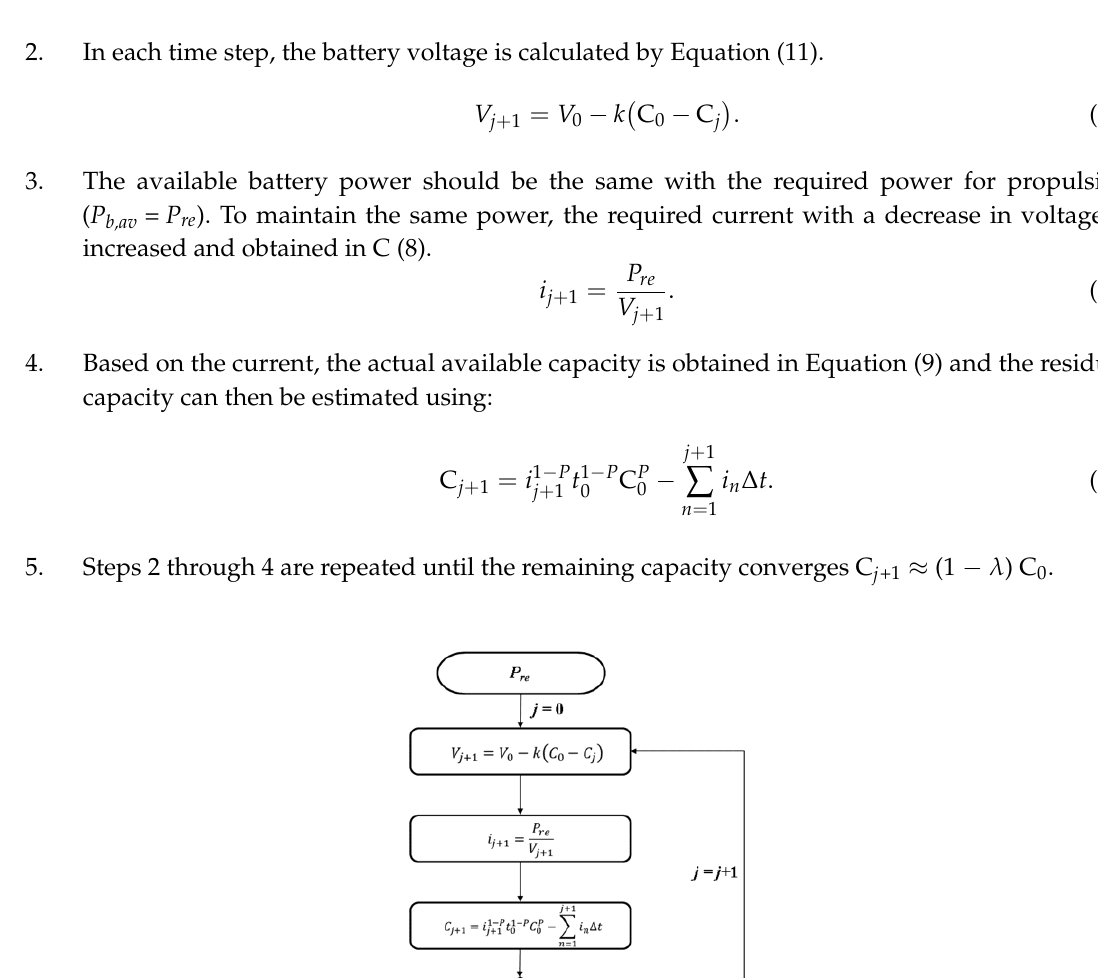
Figure 4. Multirotor UAV used for numerical predication and experimental validation. Figure 5. Required power and thrust of rotor (propeller + motor) as a function of the rotating speed which is changed by changing throttle from 50 to 100%. The data is provided by manufacturer.